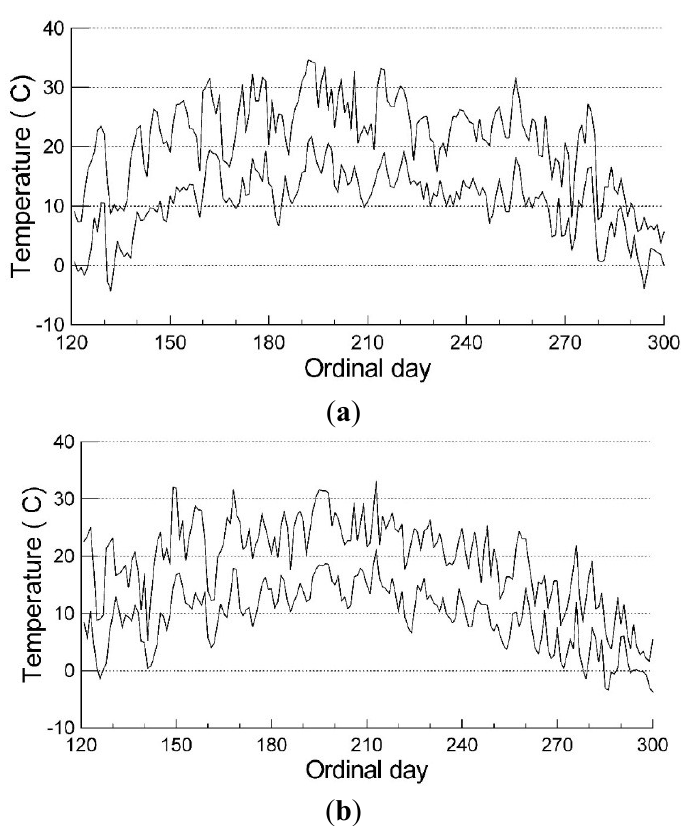
Figure A1. Daily minimum and maximum temperatures during the growing seasons 2005 ( a ) and 2006 ( b ) at the Sudbury airport, 25 km NE from the study site